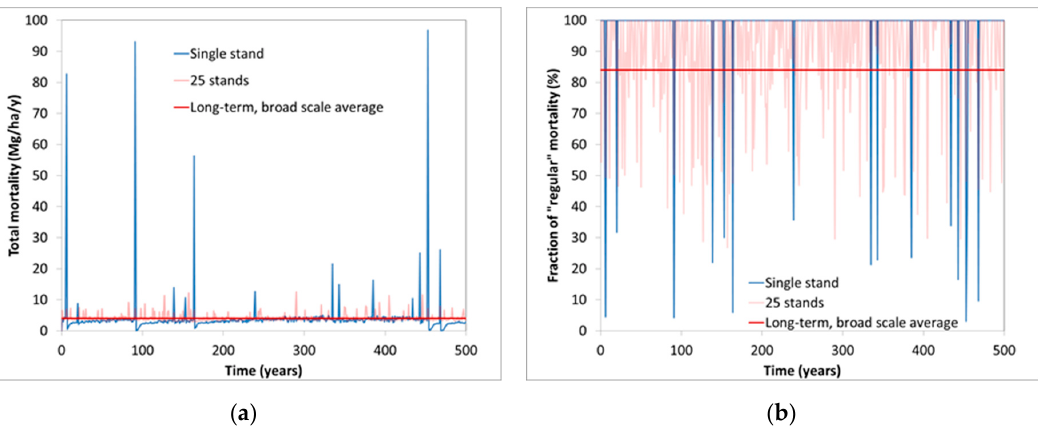
Figure 1. Example of viewing mortality as a continuum of multiple processes at three different scales: ( a ) Total mortality as the result of “regular” processes (leaf and fine root turnover, branch and coarse root pruning, and individual tree mortality) and disturbance. ( b ) The fraction of total mortality contributed by regular mortality processes. The model included two disturbance regimes: a low severity (1%–25% mortality) one with an average frequency of 100 years and a high severity (75%–100% mortality) one with an average frequency of 200 years. See Appendix A for more details about the model used.